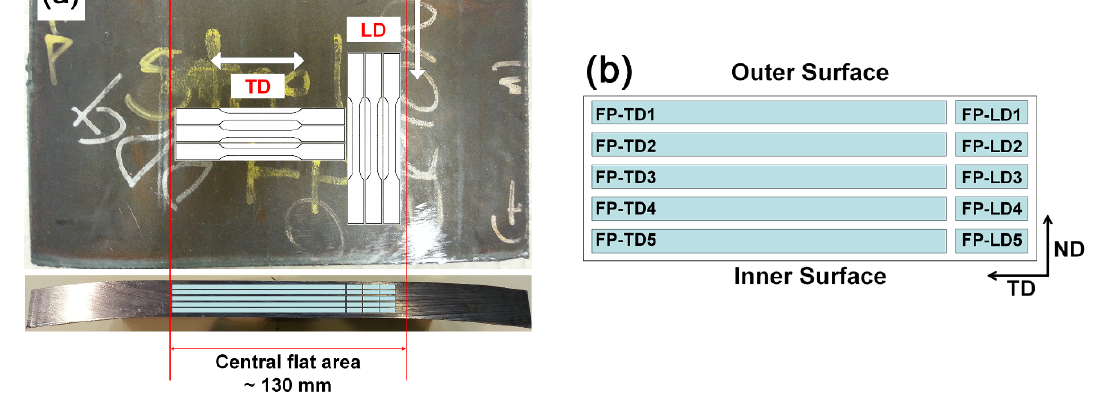
Figure 2. ( a ) A flattened sample (surface and cross-sectional views) with projection of tensile specimen positions along the longitudinal direction (LD) and the transverse direction (TD), and ( b ) through-thickness tensile specimen arrangement in steel FP (ferrite/pearlite). The test specimens closest to the outer surface are denoted TD1 and LD1 and the reference number increases toward the inner surface.